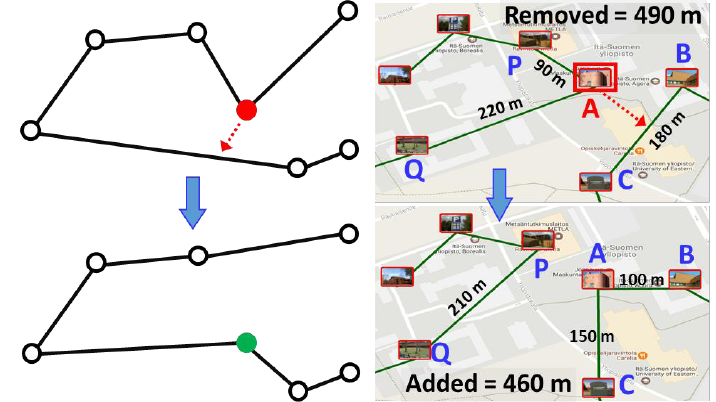
Figure 3. Working of the relocate operator and an example of how it improves the tour in an O – Mopsi game by 30